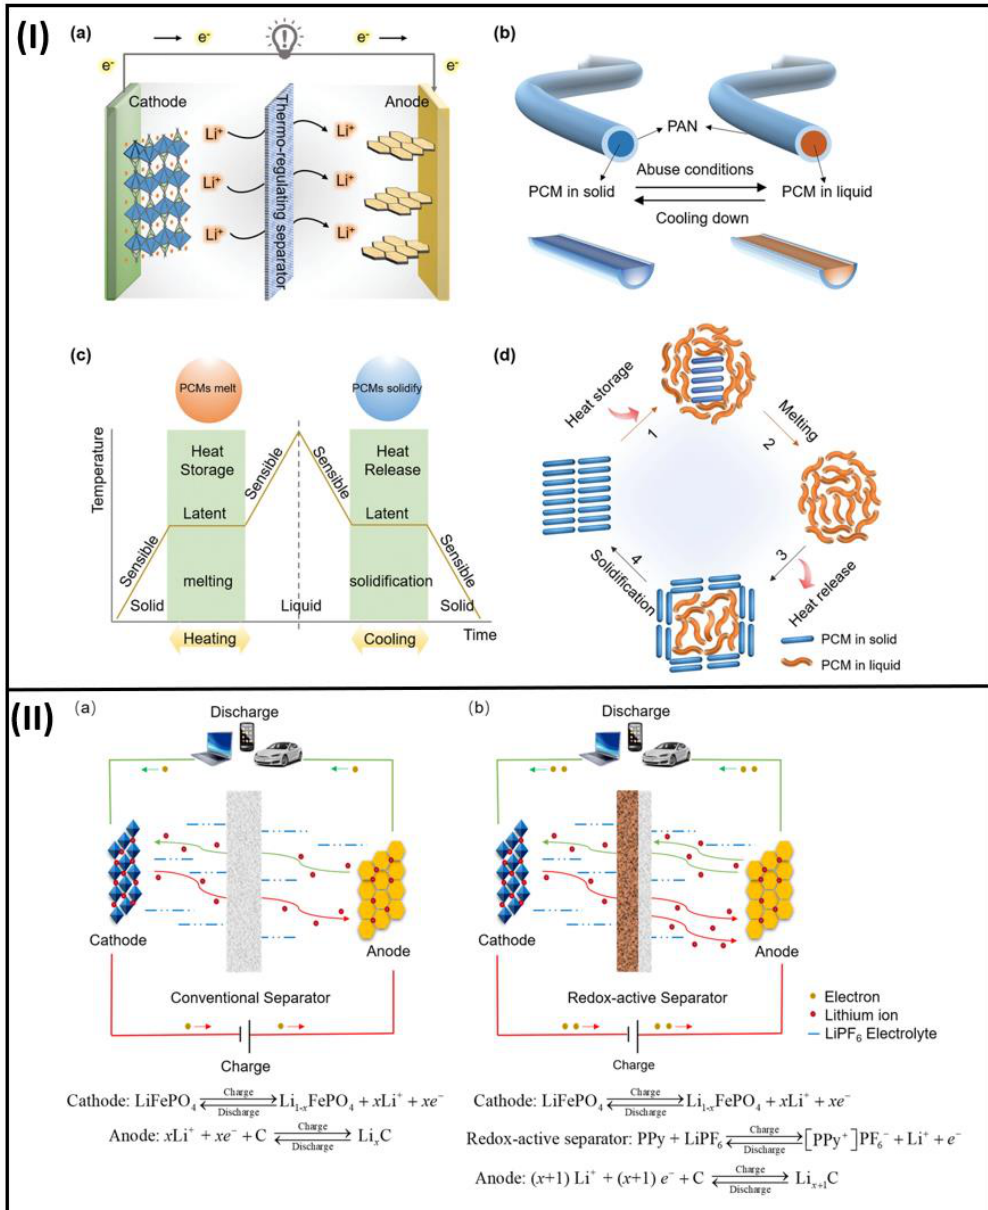
Figure 7. ( I ) An example of a schematic for a thermoregulating separator that lowers the internal temperature of LIBs under abusive situations ( a ) Design of the thermoregulating separator with LIBs. ( b ) The thermoregulating separator’s schematic arrangement. ( c ) The thermoregulating separator’s approach for regulating the interior temperature of LIBs ( d ) A change in the specific structure of PCMs because of heat absorption and heat release (reused with copyrights from Ref. [76] 2021, Wiley) ( II ) Working of LFP/Li Batteries ( a ) with Conventional Separator ( b ) with novel redox active Separator (reused with copyrights from Ref. [82] 2022, Elsevier).